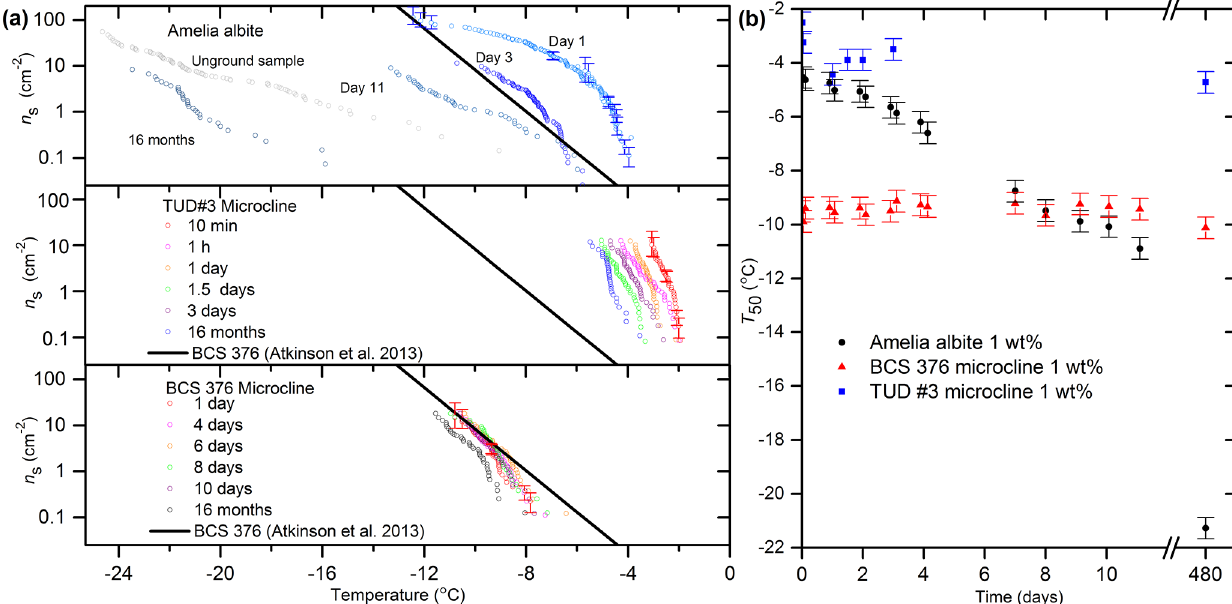
Figure 4. (a) The dependence of n s on time spent in water for three feldspar samples. The time periods indicate how long samples were left in contact with water. Fresh samples were tested minutes after preparation of suspensions. Note that ice nucleation temperatures of BCS 376 are almost the same after 16 months in water while those of Amelia albite decreases by around 16 ◦ C. TUD #3 microcline loses activity quickly in the first couple of days of exposure to water but total decrease in nucleation temperatures after 16 months is only around 2 ◦ C. (b) Median freezing temperature against time left in suspension for BCS 376 microcline, TUD#3 microcline and Amelia albite. For clarity, not all curves represented by points in panel (b) are included in panel (a)